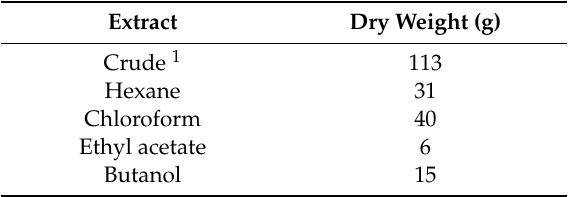
Table 1. Dry Weight of Extracts from Simarouba tulae Leaves.